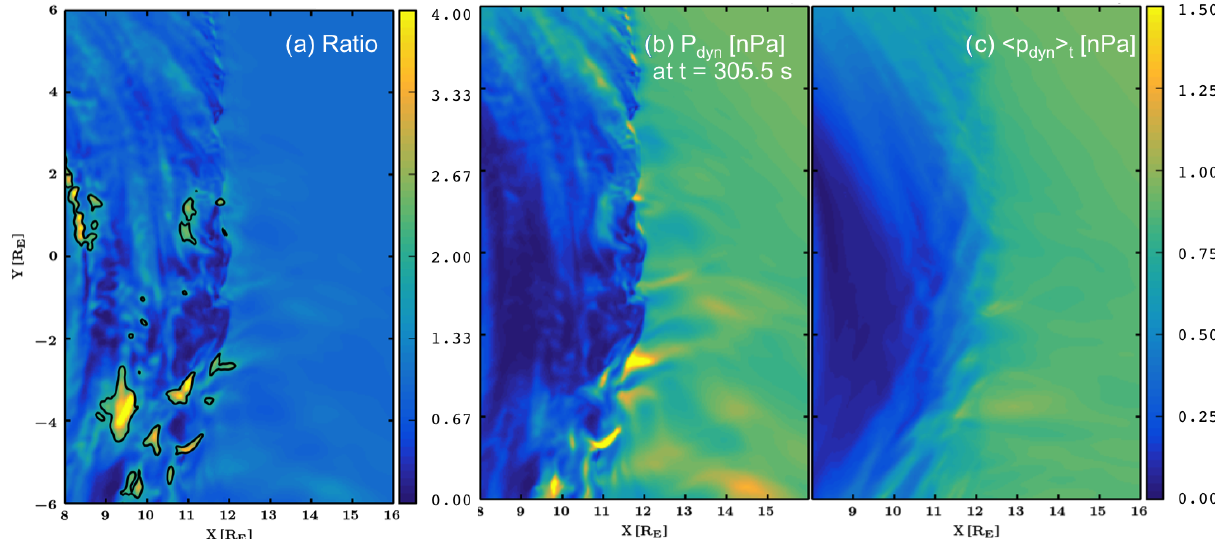
Figure 3. (a) The Archer and Horbury (2013) criterion defined in Eq. (2), devised from the ratio of (b) the dynamic pressure and (c) the temporal average of dynamic pressure over 3min centered at the time showing the jet-like feature in Fig. 1a. Panel (a) shows a contour marking the locations where the ratio of panel (b) and (c) exceeds 2. Panels (b) and (c) have the same scale, from 0 to 1.5nPa.